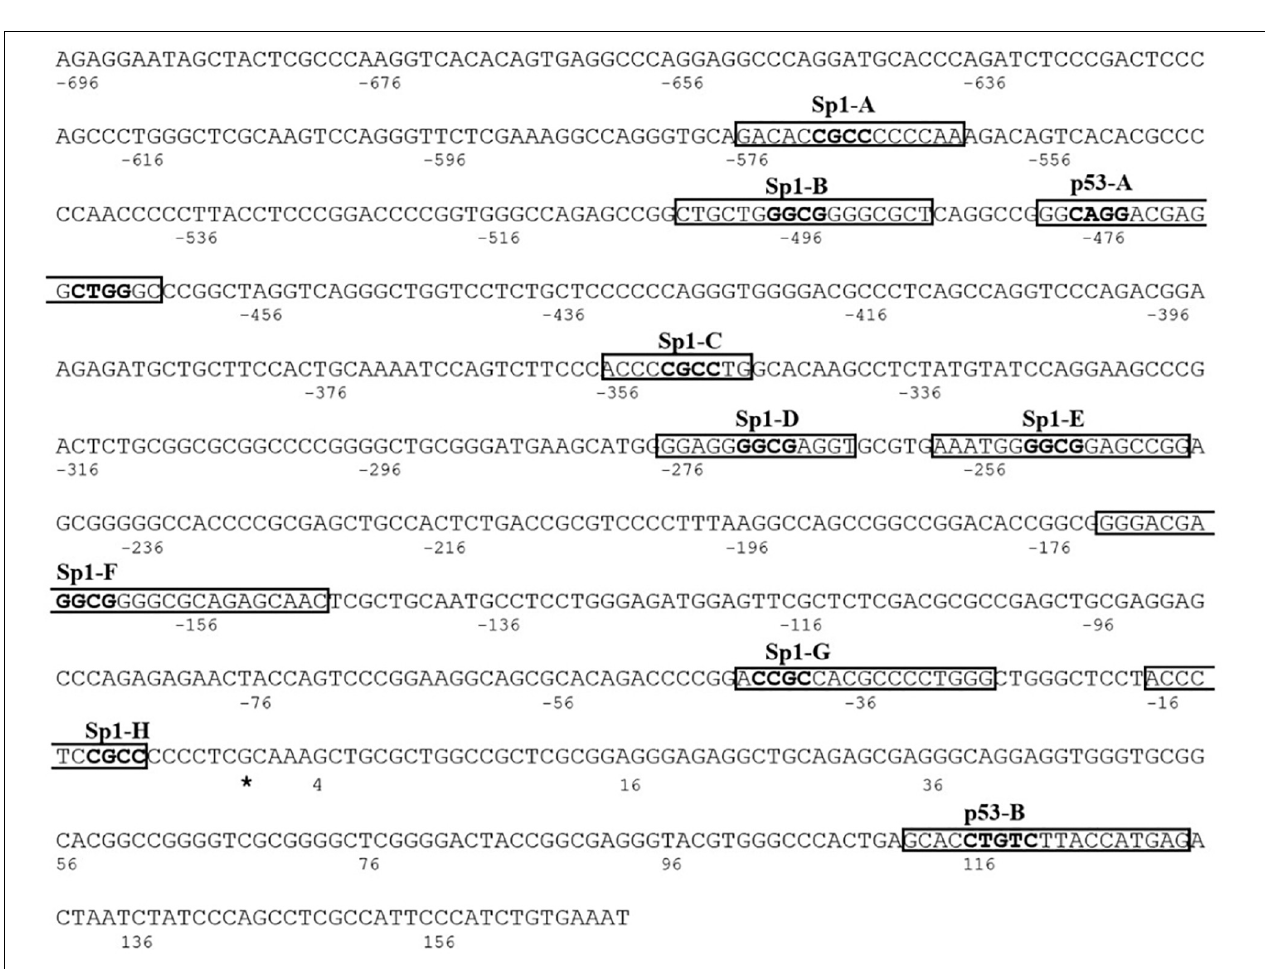
FIGURE 1 | The human KCTD-containing Cullin3 Adaptor of Suppressor of Hedgehog 2 (KCASH2) proximal promoter. The Transcription Start Site (TSS) is identified with the asterisk and is considered as nucleotide number 1. The putative binding sequences for Sp1 and p53 TFs are named from A to H and A to B, respectively. The relative core sequences are highlighted in